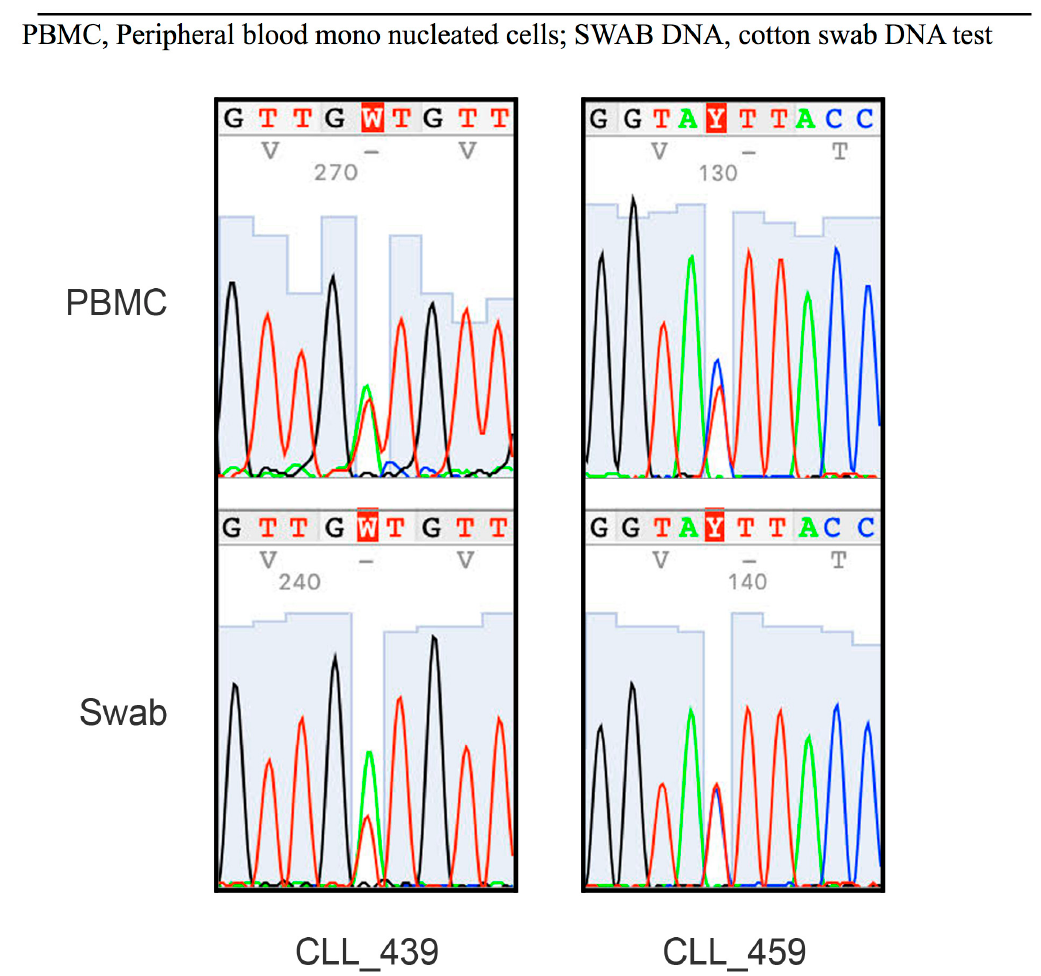
Figure 2. BUB1 mutational analysis in CLL patients. Sequence analysis of BUB1 from peripheral blood mononuclear cells (PBMC) and cotton buccal swab specimens (SWAB) genomic DNAs from two CLL patients with BUB1 missense point mutations. Alignment was performed using the reference sequence NM_004336.